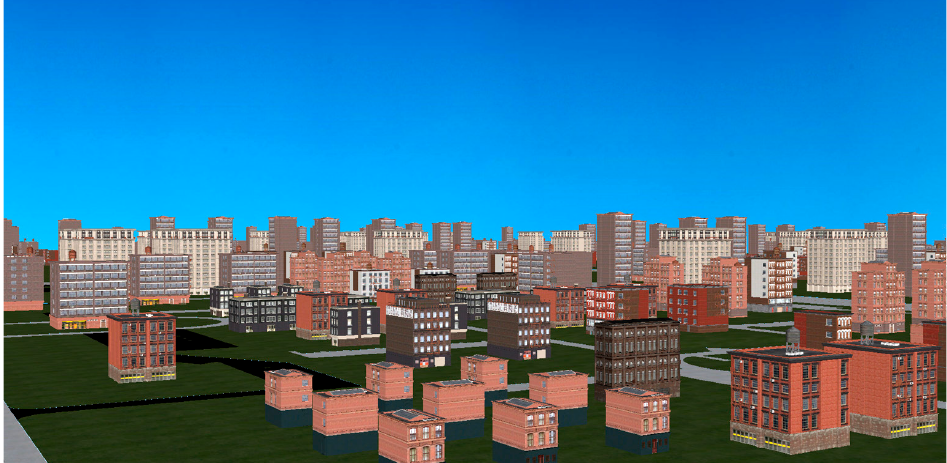
Figure 15. Urban